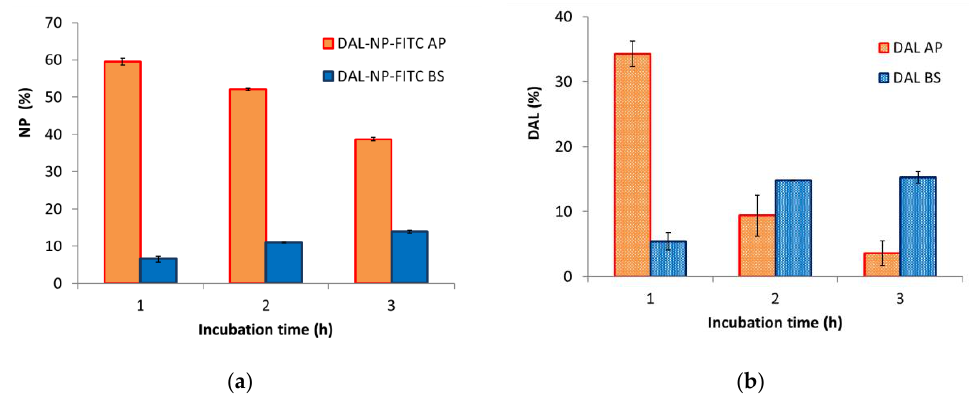
Figure 5 . Permeation through Caco-2 monolayers. Time course of content in apical (AP) and basolateral (BS) chambers of ( a ) polymeric carrier DAL-NP-fluorescein isothiocyanate-dextran (FITC), made fluorescent with covalently labelled FITC, and ( b ) drug carried by the nanoparticles (DAL); data are the means ± standard deviation (SD) of three independent ex- periments.